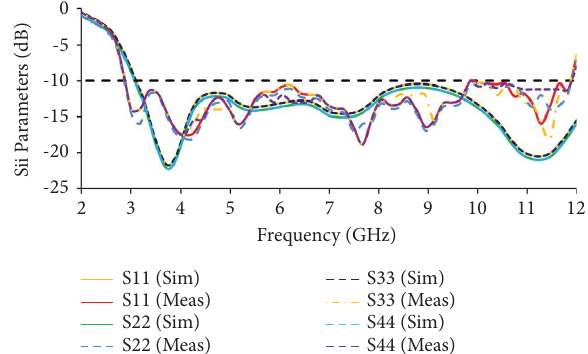
Figure 10: S ii -plots of the proposed MIMO antenna.